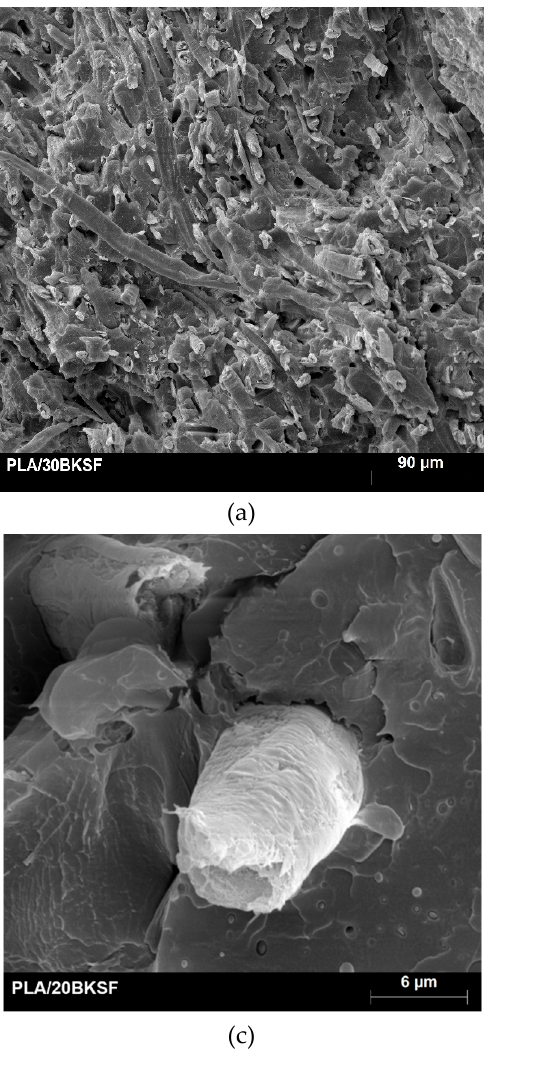
Figure 6. SEM micrographs of the fractured sections; ( a ) and ( d ) from a composite with a 30 wt % of BKSP; ( b ) from a composite with a 10 wt % of BKSP; ( c ) from a composite with a 20 wt wt % of BKSP.